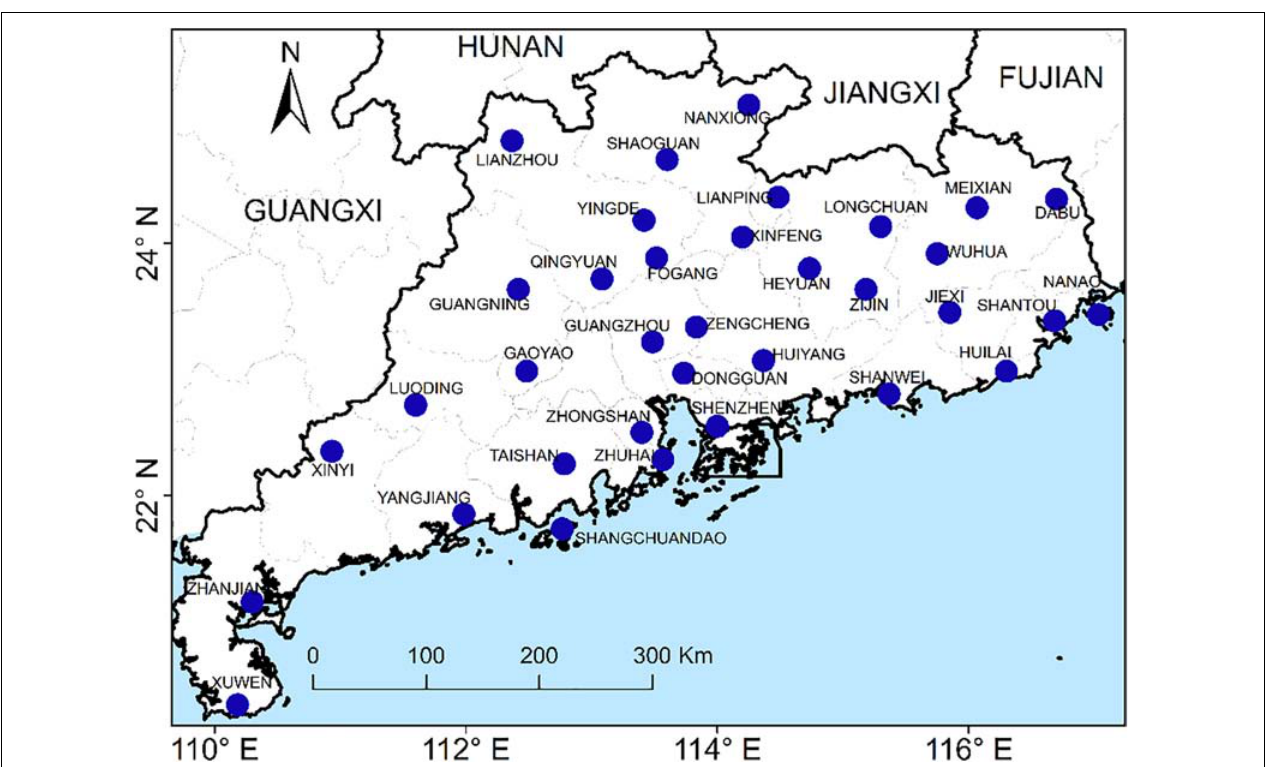
FIGURE 2 | Geographical positions of the 16 weather stations over Guangdong Province, China.